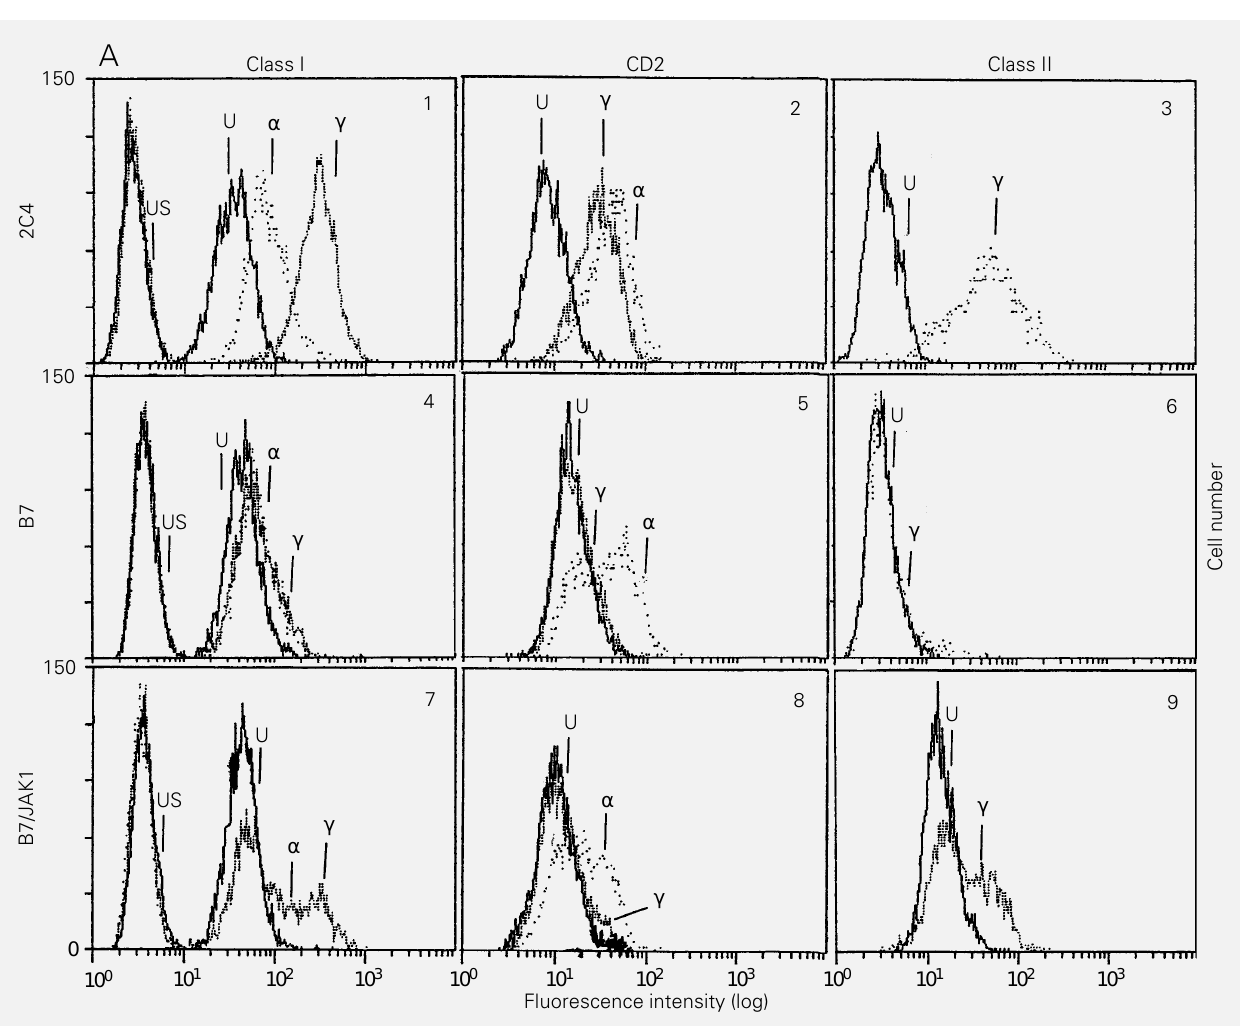
Figure 1 - FACS analysis of the parental and mutant cell lines. A , 2C4, B7 and B7/JAK1 transfectants and B , genetic crosses B7/U3 and B7/U4. The expression of the cell surface markers CD2 (panels 2,5,8,11,14) and endogenous class I (panels 1,4,7,10,13) and class II HLAs (panels 3,6,9,12,15) upon IFN- a or IFN- g stimulation (500 IU/ml for 48 h) was monitored by FACS analysis as described in Material and Methods. Transfectants were analyzed as a population. Panels 1-3 : Parental cell line 2C4; panels 4-6 : B7 cell line; panels 7-9 : B7/JAK1 transfectants; panels 10-12 : genetic cross between B7 and the U3 mutant; panels 13-15 : genetic cross between B7 and the U4 mutant. Untreated cells (U), IFN- a ( a ) or IFN- g ( g ) treated cells, and unstained cells (US) as indicated. US cells were left untreated or IFN- a treated, but were not incubated with any